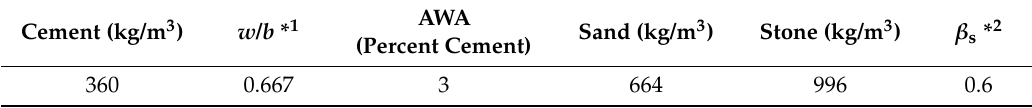
Table 3. The mix ratio of AWC.